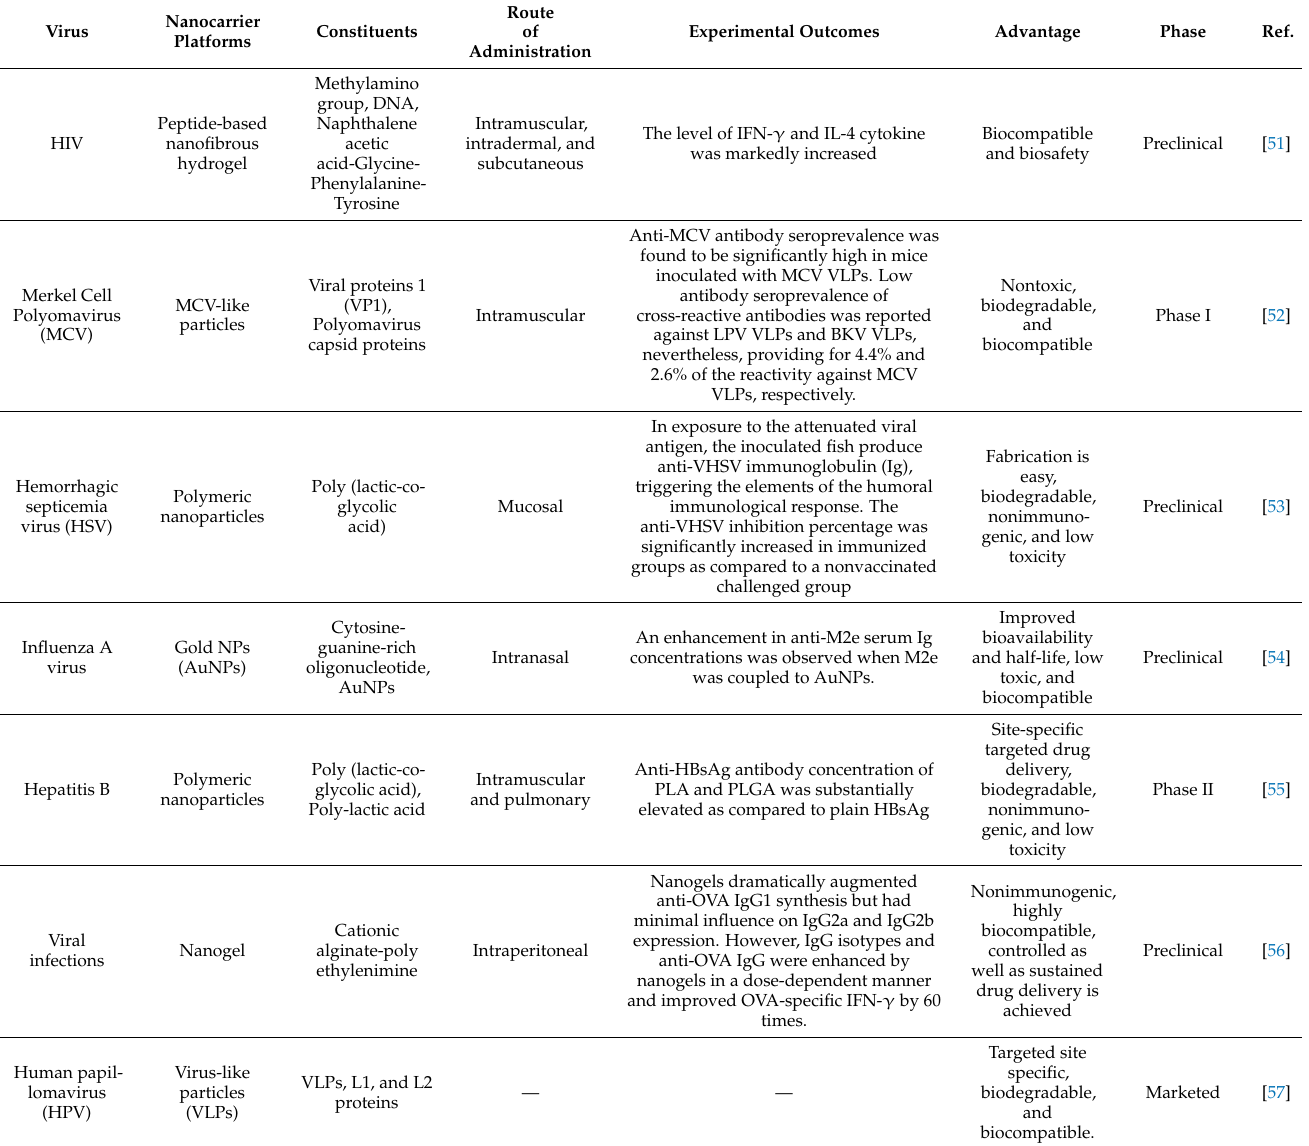
Table 2. Overview of viral therapeutics using nanocarrier